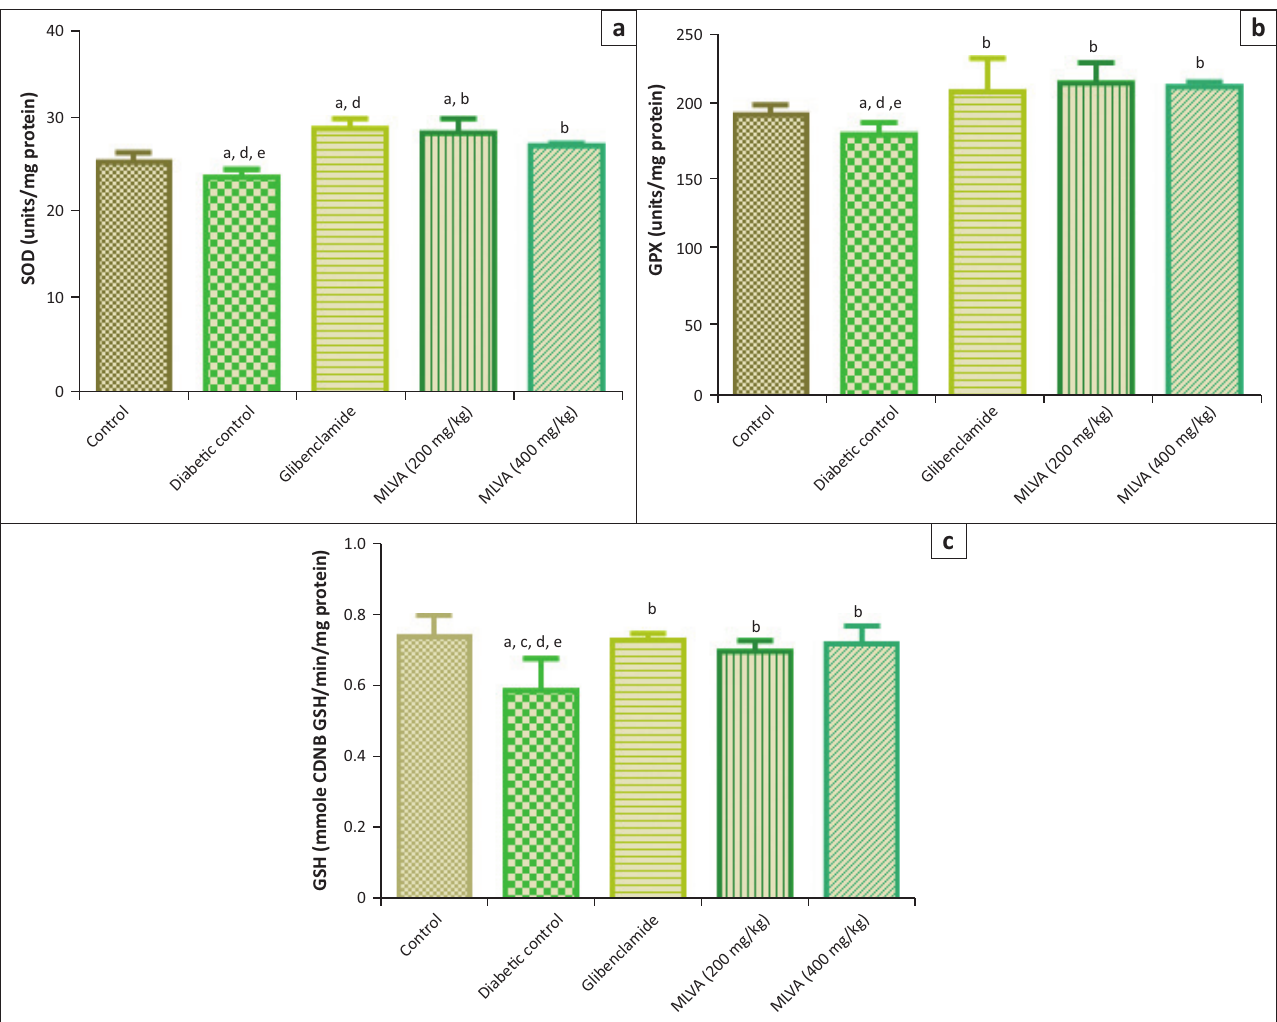
FIGURE 4: Effect of methanol leaf extract of Vernonia amygdalina (MLVA) on (a) superoxide dismutase (SOD), (b) glutathione peroxidase (GPx) and (c) glutathione- S-transferase (GST) activities in intestinal tissue of alloxan-induced diabetic rats. Values are mean ± SD, n = 5, a p < 0.05 compared with control, b p < 0.05 compared with diabetic control, c p < 0.05 compared with glibenclamide, d p < 0.05 compared with MLVA, 200 mg/kg and e p < 0.05 compared with MLVA, 400